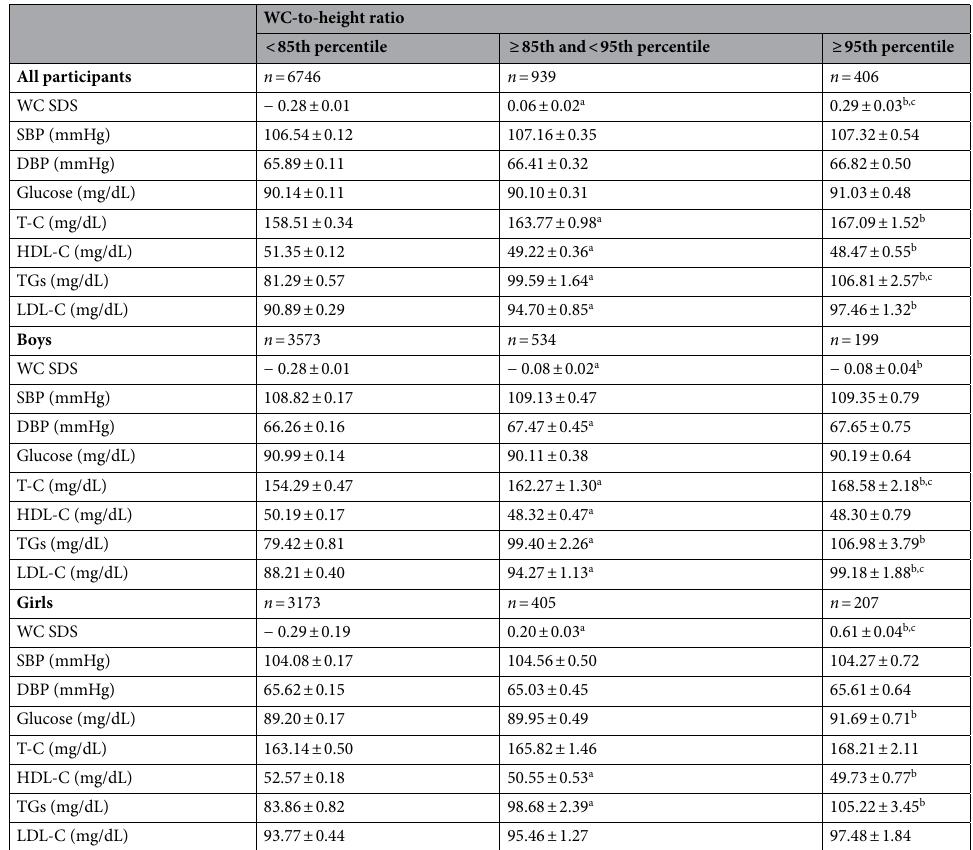
Table 3. The adjusted means of cardiometabolic risk factors according to waist circumference-to-height ratio (WHtR) in Korean children and adolescents ( n = 8091). The results are expressed as the mean ± standard error (SE). The adjusted means of cardiometabolic risk factors were estimated using analysis of covariance (ANCOVA) with Bonferroni’s post hoc test after adjustment for age, sex, body mass index (BMI) standard deviation score (SDS), alcohol consumption, smoking, physical activity, residence, household income, and diagnosis of hypertension, diabetes mellitus and dyslipidemia. WC waist circumference, SDS standard deviation score, BMI body mass index, SBP systolic blood pressure, DBP diastolic blood pressure, T-C total cholesterol, HDL-C high-density lipoprotein cholesterol, TGs triglycerides, LDL-C low-density lipoprotein cholesterol. a The difference was estimated between the < 85th percentile group and the ≥ 85th and < 95th percentile group using analysis of covariance with Bonferroni’s post hoc test. b The difference was estimated between the < 85th percentile group and the ≥ 95th percentile group using analysis of covariance with Bonferroni’s post hoc test. c The difference was estimated between the ≥ 85th and < 95th percentile group and the ≥ 95th percentile group using analysis of covariance with Bonferroni’s post hoc